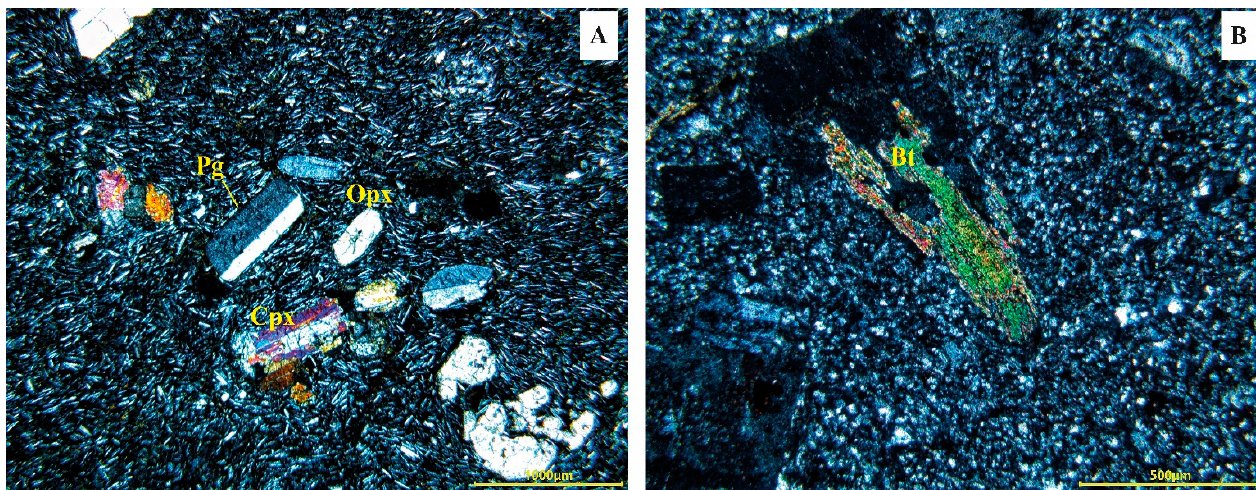
Figure 5. Thin-section photomicrographs of andesites from Tiddas and the ARM 15 sample. ( A ) Tiddas andesite with plagioclase (Pl), clinopyroxene (Cpx), and orthopyroxene (Opx); ( B ) sample ARM15 of a rhyolitic dome with biotites (Bt).